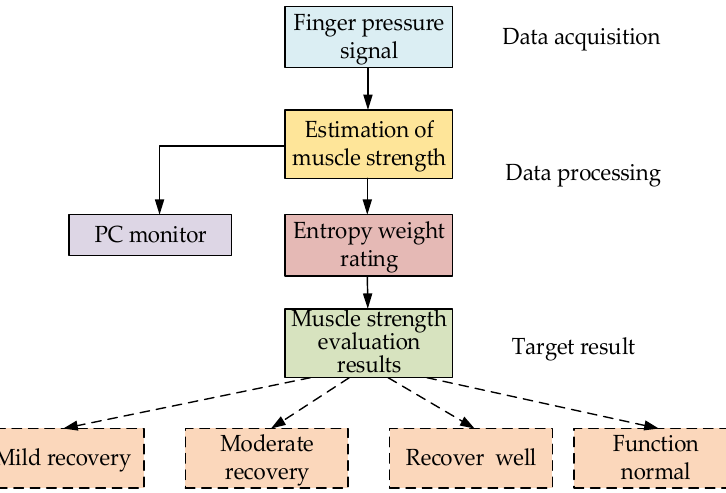
Figure 10. Muscle strength assessment model